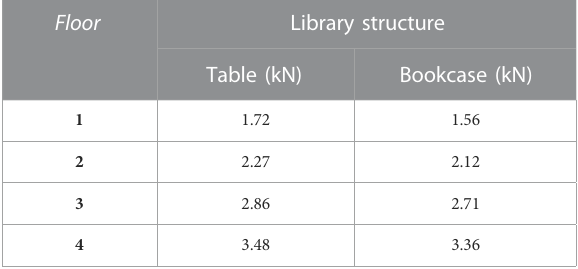
TABLE 9 Seismic design forces of NEs for TBEC-2018 (Cavuslu,